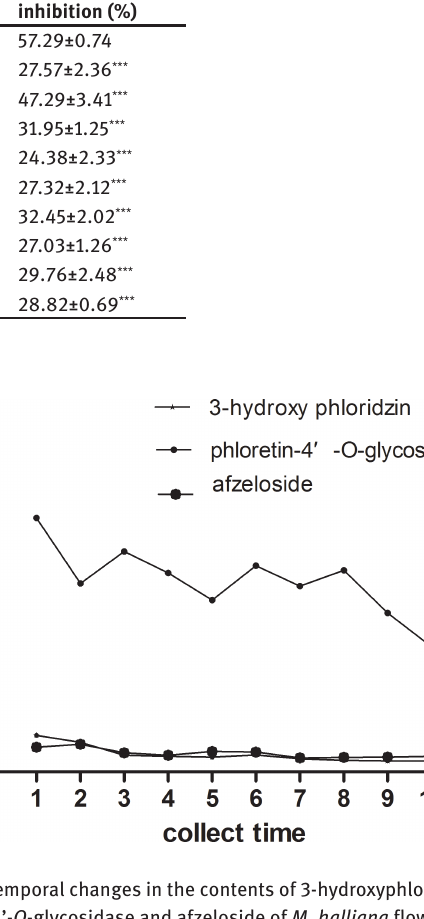
Table 2: Content determination and inhibitory effect of M. halliana flowers on α- glucosidase (n=3). Collection